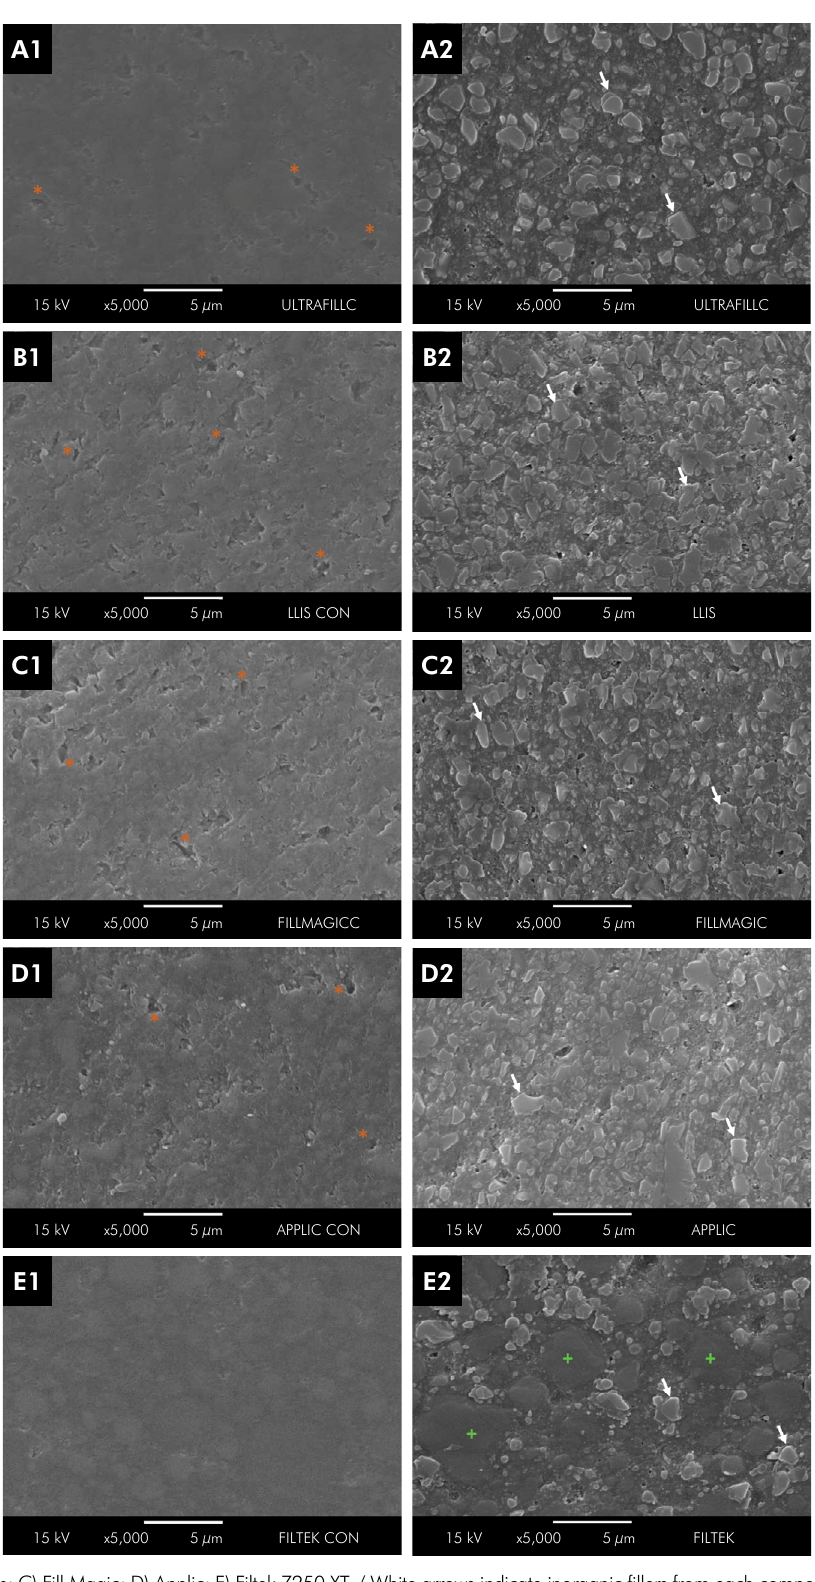
Figure. SEM images (5,000x magnification) showing the surface before (1) and after (2) simulated tooth brushing of each composite group.